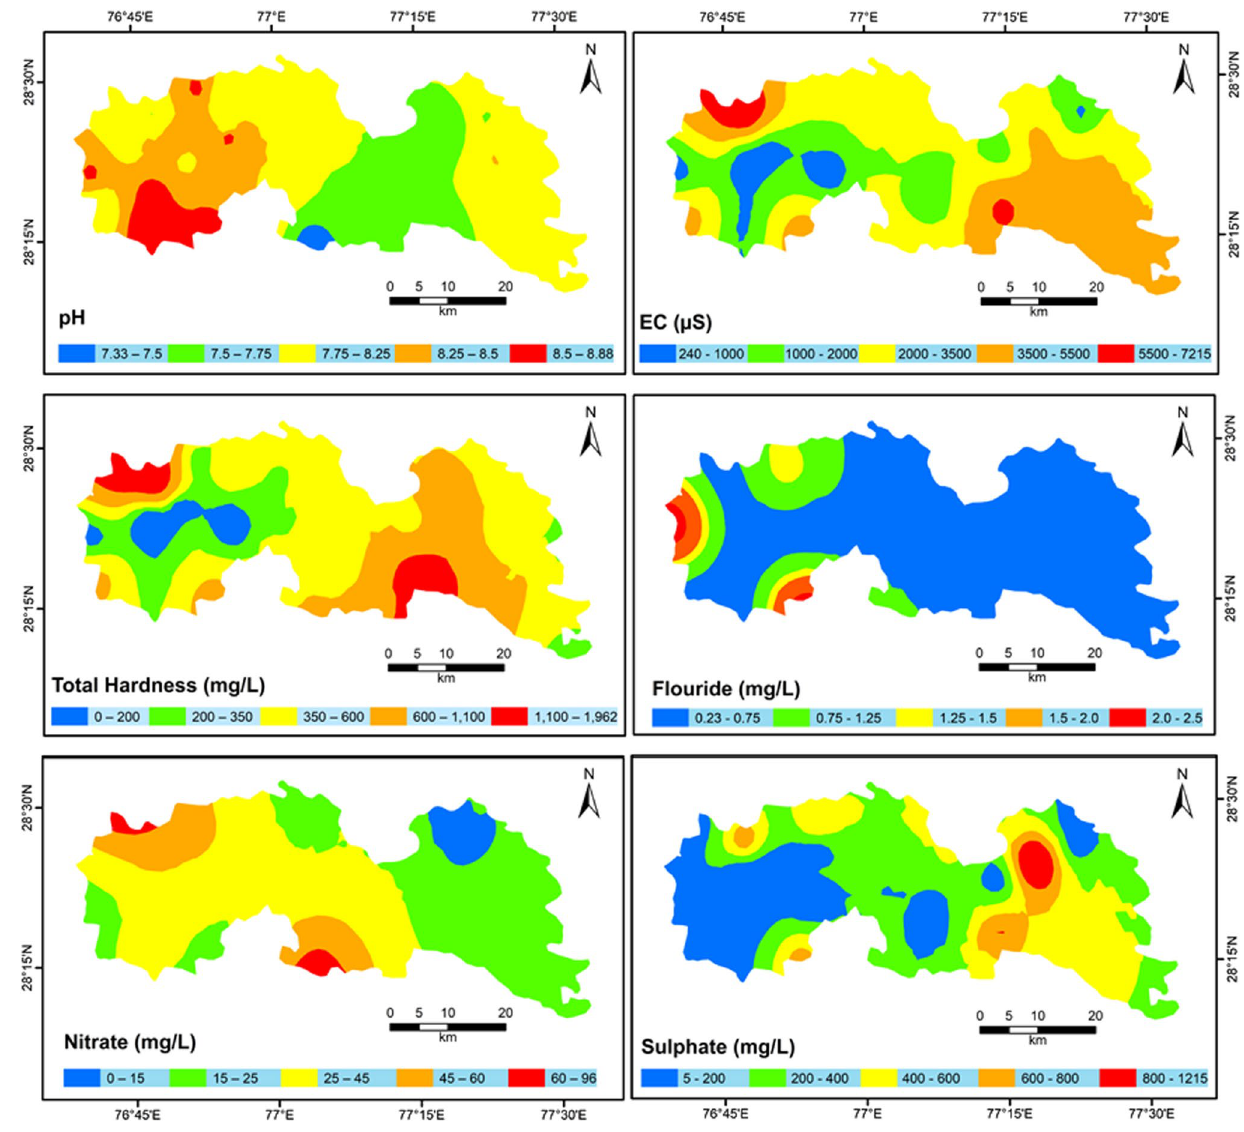
Fig. 3 Geospatial mapping of the water quality parameters over the study